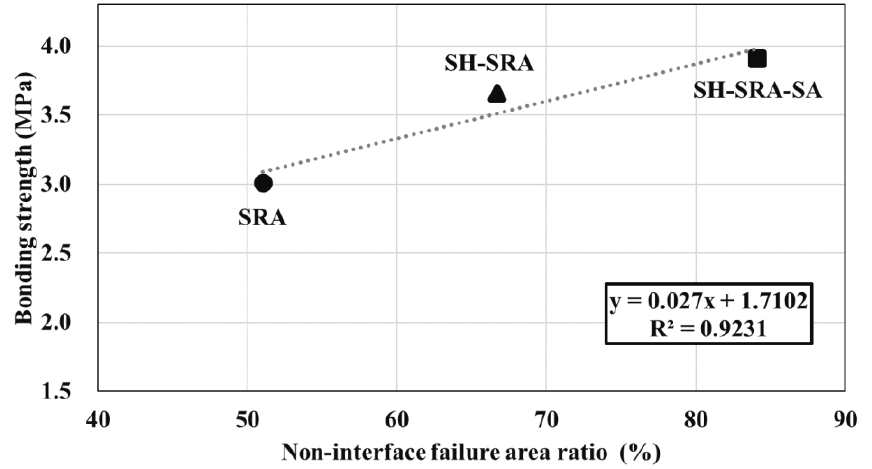
Figure 10. Relationship between bonding strength and non-interface failure area ratio.